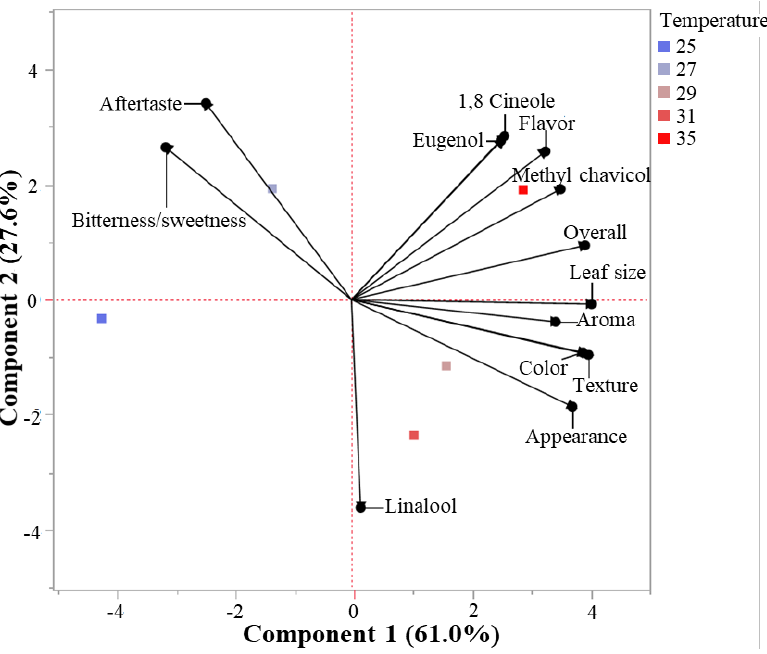
Figure 3. Sensory preference and volatile organic compound principal component analysis. Principal component analysis showing biplot differentiation of sweet basil ( Ocimum basilicum ‘Nufar’) grown at mean daily temperatures (MDT) from 23 to 36 ◦ C for three weeks, based on consumer sensory preferences ( n = 86) and the concentration of two terpenoids and two phenylpropanoids ( n = 15).